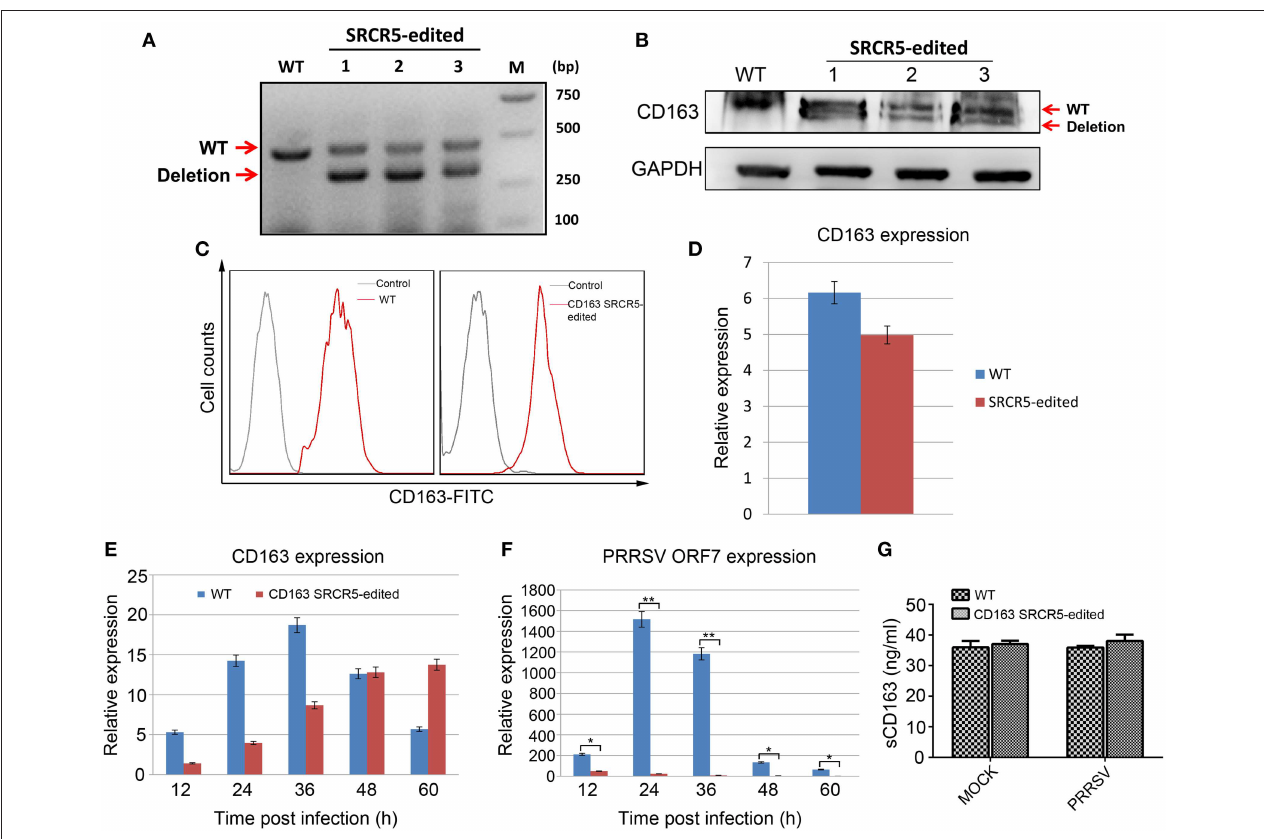
FIGURE 7 | Resistance of PAMs isolated from CD163 SRCR5-edited piglets to PRRSV 2 in vitro . (A) RT-PCR analysis of CD163 expression in PAMs from three heterologous offspring of CD163 SRCR5-edited Large White pig 13. (B) Western blot analysis of CD163 protein expression from three heterologous offspring of CD163 SRCR5-edited Large White pig 13. (C) Expression of membranous CD163 in CD163 SRCR5-edited and WT PAMs was detected by flow cytometry. The gray line represents control cells and the red line represents the CD163-FITC positive cells. (D) CD163 mRNA expression was determined by qRT-PCR in SRCR5-edited cells and WT cells. (E,F) CD163 SRCR5-edited PAMs and WT controls were infected with JXA1 strain (MOI = 1). The expression of CD163 and PRRSV ORF7 was detected at 12, 24, 36, 48, and 60h post infection (hpi). (G) CD163 SRCR5-edited PAMs and WT controls were either mock infected or infected with JXA1 strain (MOI = 1) for 24h. The level of soluble CD163 in the supernatants was measured using an ELISA kit. Data are representative of the results of three independent experiments (means ± SE). Significant differences are indicated as follows: * P < 0.05, ** P <